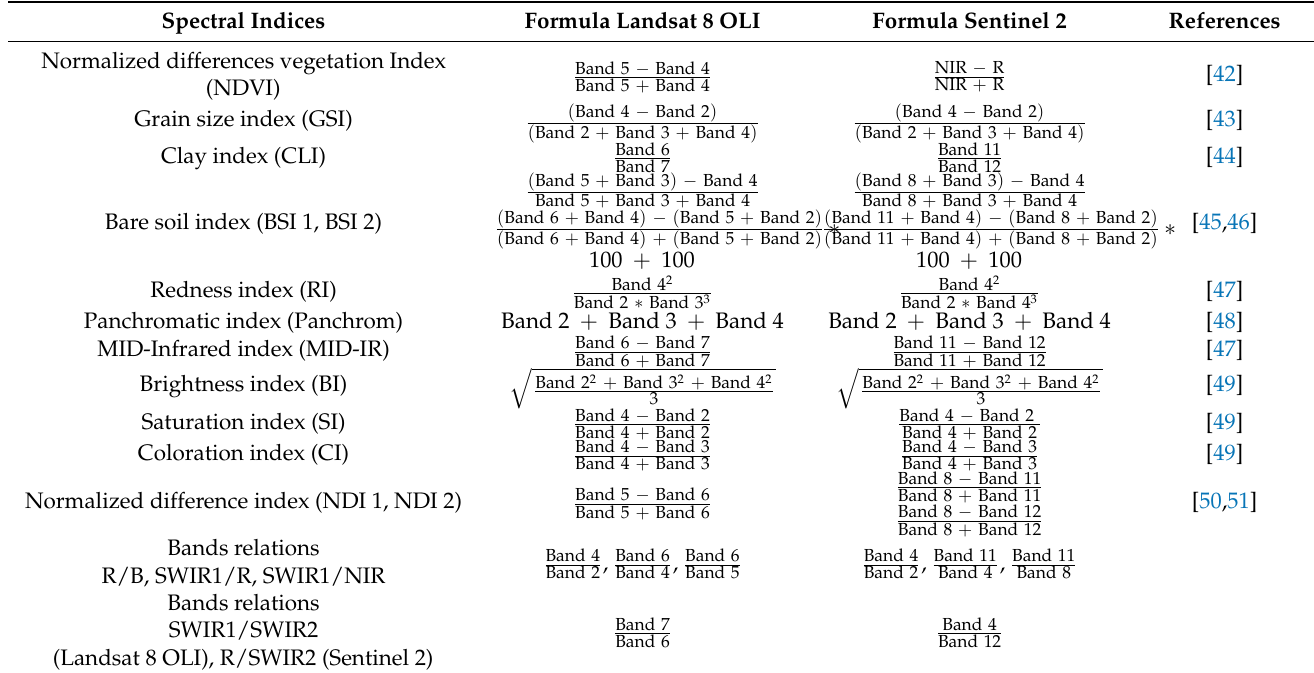
Table 1. Spectral indices and formulas for their